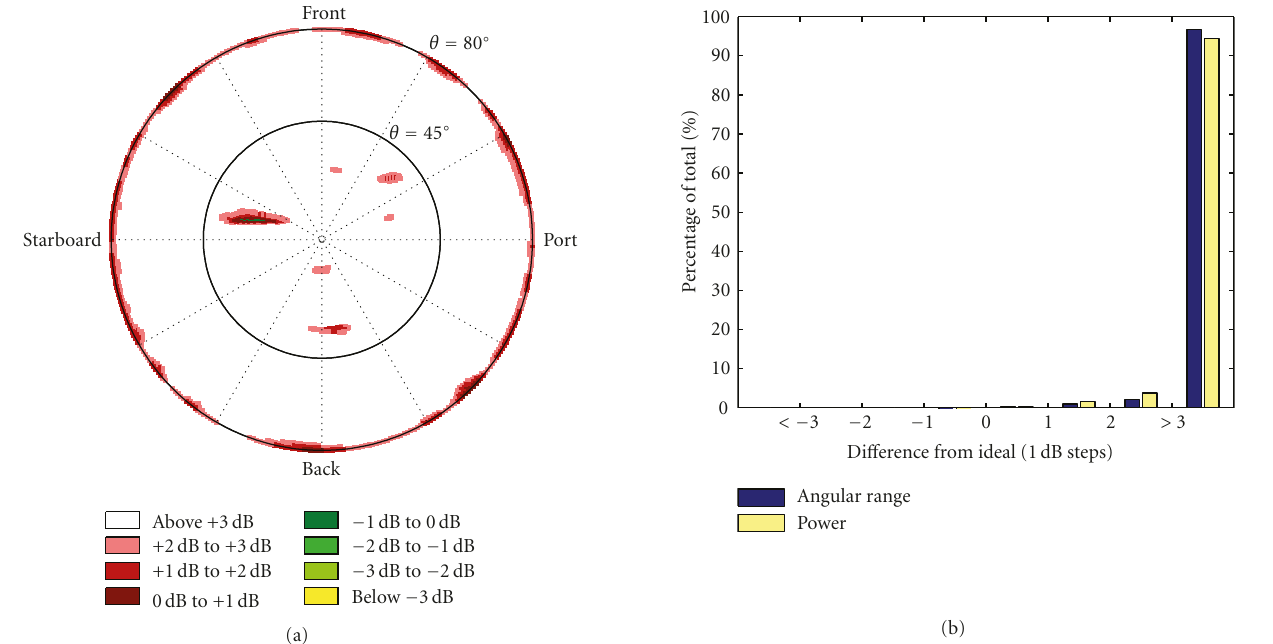
Figure 17: Assessment of radiation pattern of single turn helical antenna with stando ff cone on the gondola normalised to θ = 80 ◦ minima; (a) flattened hemisphere plot of gain comparison to ideal radiation pattern shape, (b) radiation pattern power distribution in relation to ideal radiation pattern shape, from